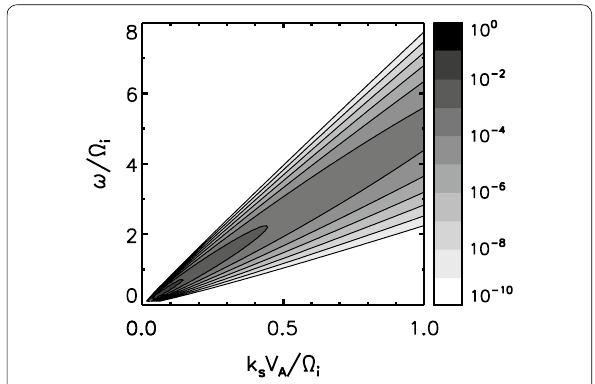
Fig. 1 Energy spectrum in the wavenumber–frequency domain for the random sweeping model. Color bar scale shows levels of the spectral energy density in the wavenumber–frequency domain, so the squared fluctuation amplitude divided by the frequency interval and by the wavenumber interval. The fluctuation amplitudes are normalized to the mean field (e.g., magnetic field), the frequencies to the ion cyclotron frequency, and the wavenumber interval to the ion inertial scale. The color bar scale is normalized here, and reads E / E ω k , where E ω k = B 2 0 V A /� 2